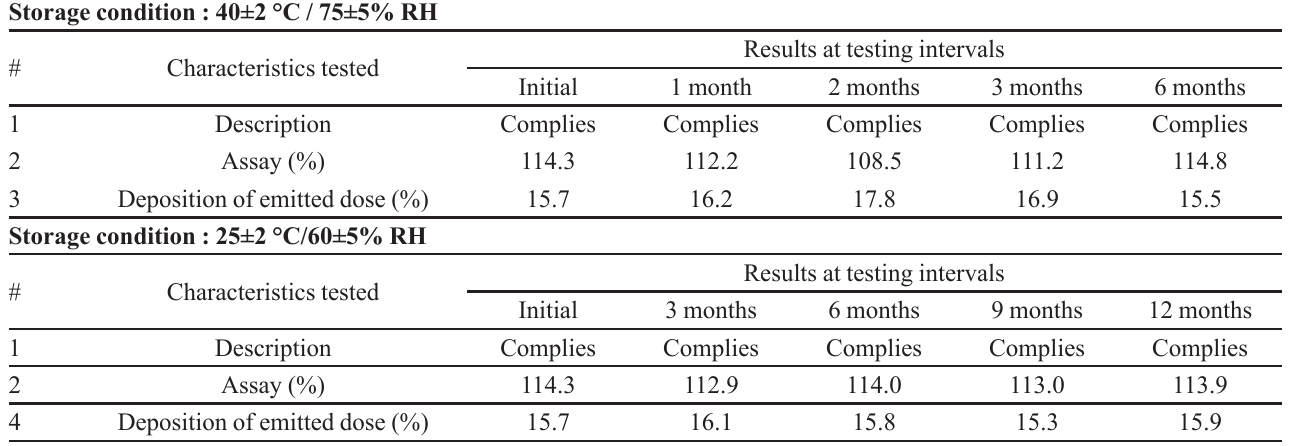
TABLE VII - Stability data of Beclomethasone DPI 200 µg stored at 40±2 °C/75±5% RH & 25±2 °C/60±5% RH Storage condition : 40±2 °C / 75±5%